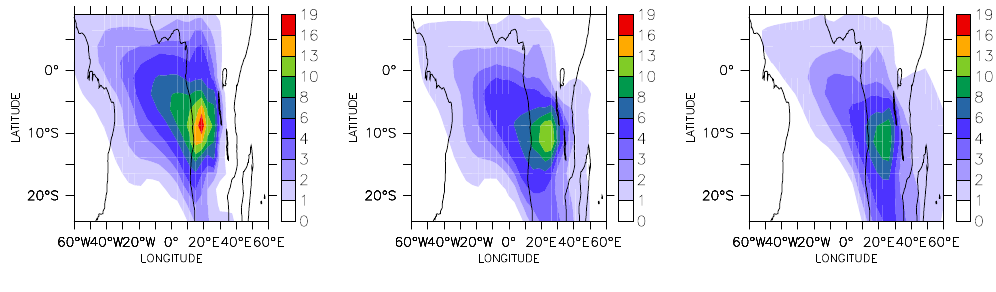
Fig. 10. Peak of the CO 2 mixing ratio vertical distribution averaged over the 20 last days of July for simulations REF (left), TH (middle) and TH with β = 0 . 1 (right).